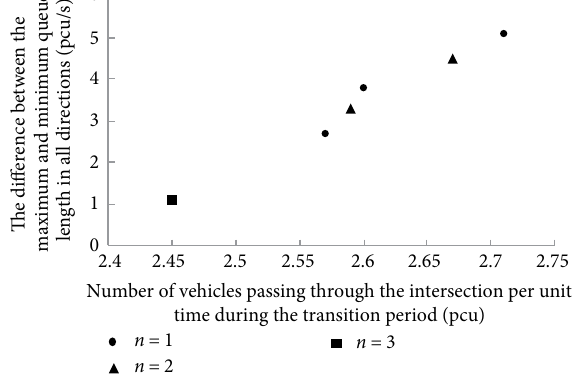
Figure 9: Pareto frontier when t